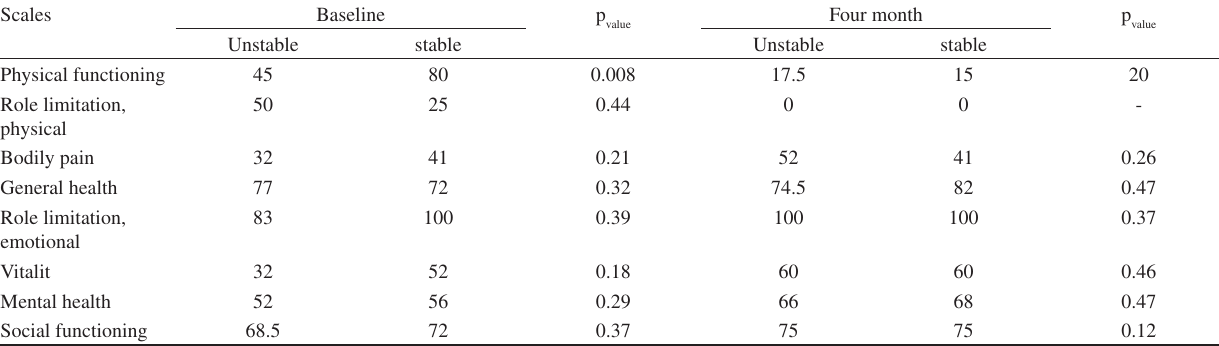
Table 5 - SF-36 scores (median) in patients with unstable and stable TF at baseline and four month follow-up